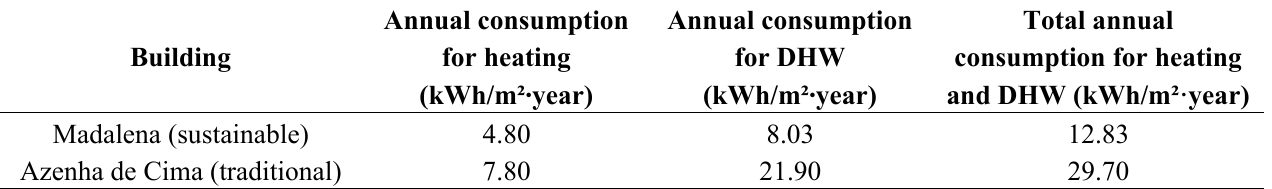
Table 10. Average annual consumptions for heating and DHW per m²—Madalena vs . Azenha de Cima.